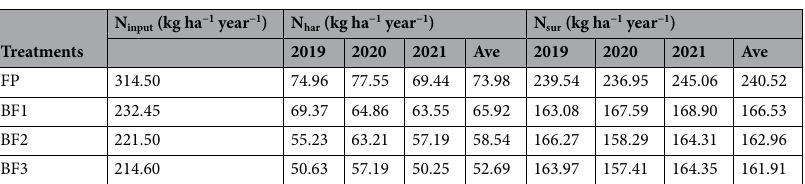
Table 4. Nitrogen input and surpluses of spring wheat among the different treatments. FP and BF indicate farmer practice and balanced fertilization, respectively.